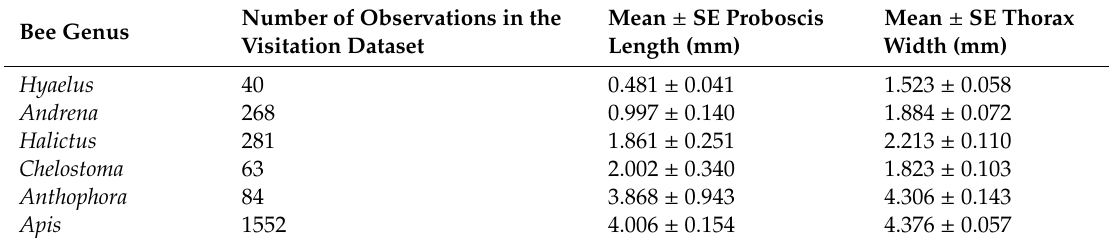
Table 5. Numbers of flower visits observed by the six bee genera during the 2015–2016 field seasons. Bees are tabulated from small to large, according to their proboscis